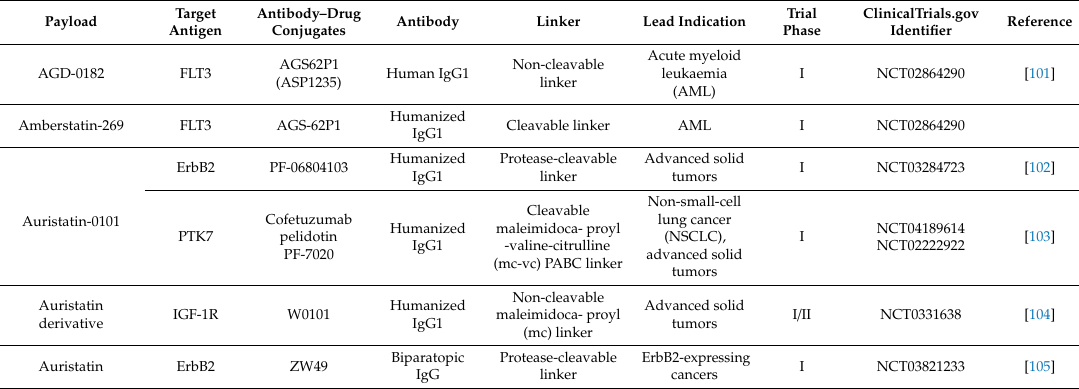
Table 3. Antibody–drug conjugates in clinical